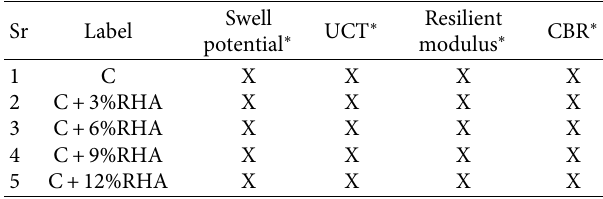
Figure 1: Physical appearance of samples used (a) clay, (b) rice husk, (c) rice husk ash, and (d) nano-SiO 2 . Table 1: Expansive clay plus rice husk ash composite tests matrix.